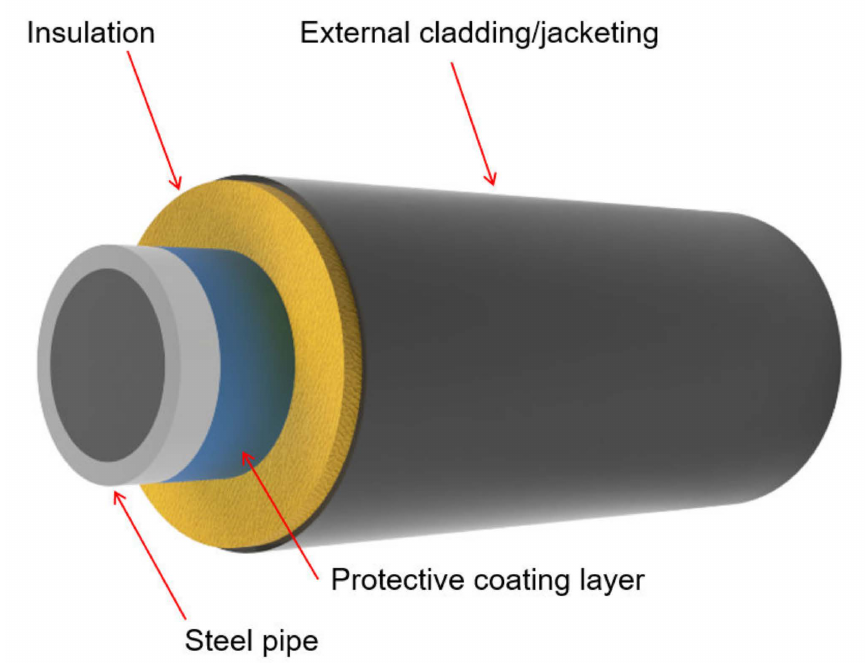
Figure 1. Schematic of a typical insulated pipe, which consists of an external cladding/jacketing, insulation material, a protective coating layer, and a steel pipe